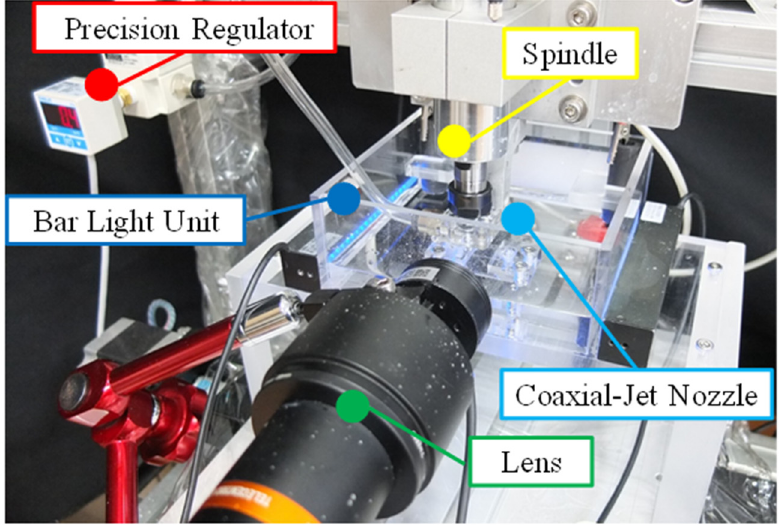
Figure 1. The experimental system architecture.